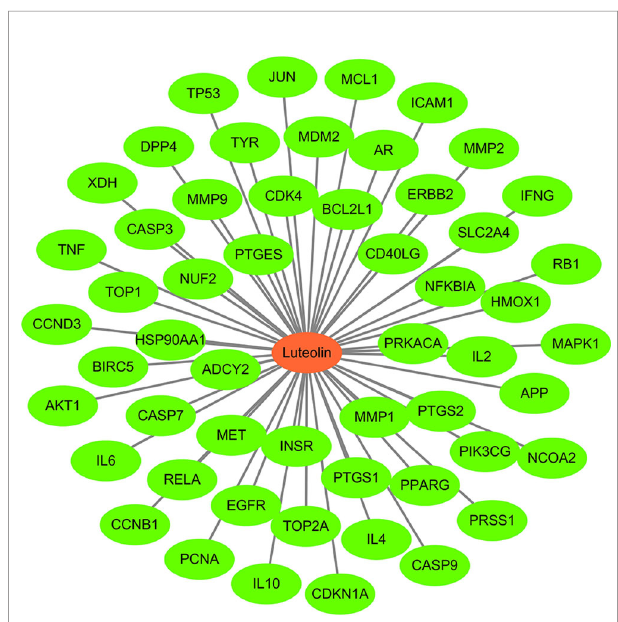
FIGURE 3 | Potential target genes related to